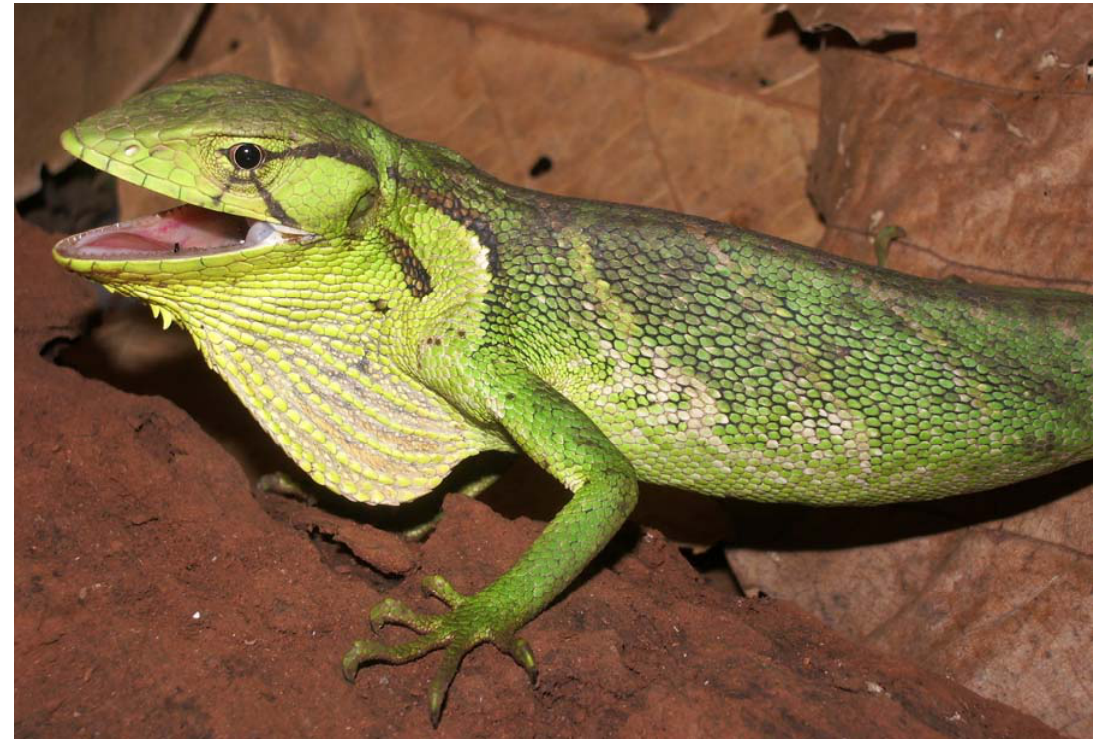
Figure 3 . Adult male P. liogaster collected at the municipality of Jauru. Photo by R. W. Ávila.